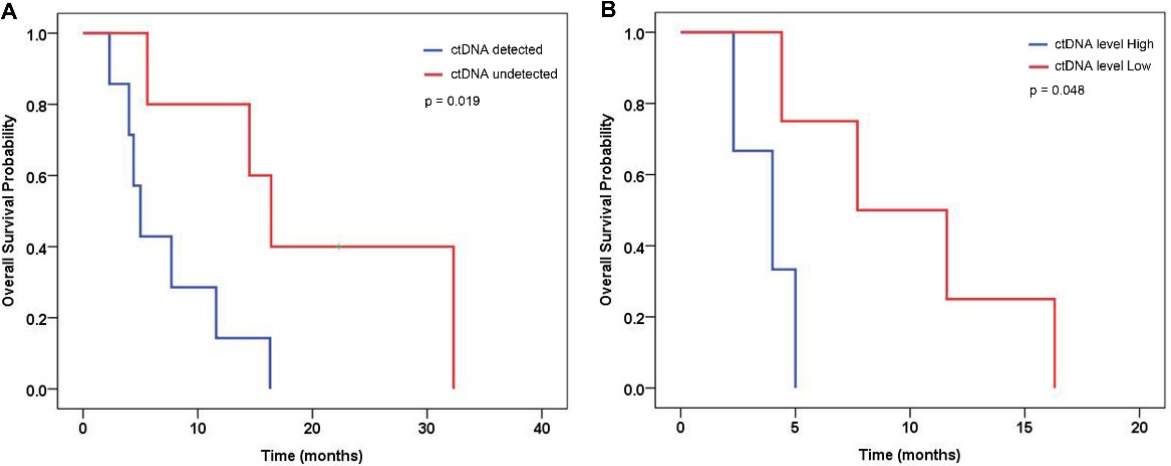
Figure 3. Changes in tumor burden in patients by detection of circulating tumor DNA (ctDNA). Patients with detected ctDNA showed rapid tumor growth when compared with those without detected ctDNA (median value of volume doubling time: 2.4 versus 5.9 months, p = 0.035).